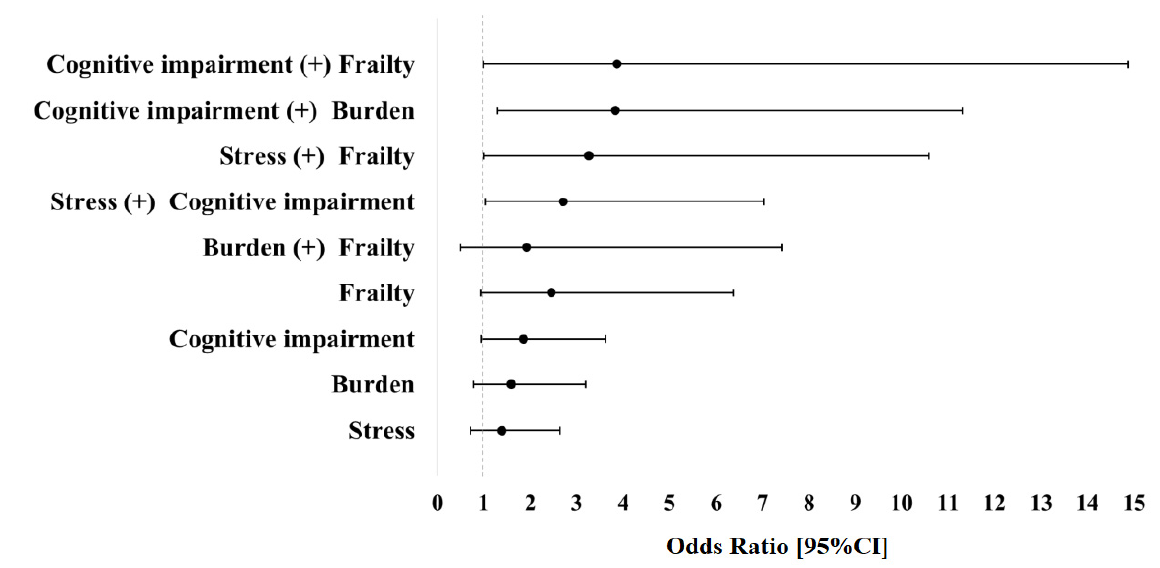
Figure 2. Forest plot for effects of accumulated conditions on hospitalization in older caregivers. X-axis denotes odds ratio with 95% confidence interval (error bars); Y-axis (left side) denotes accumulated conditions tested in association with hospitalization of older